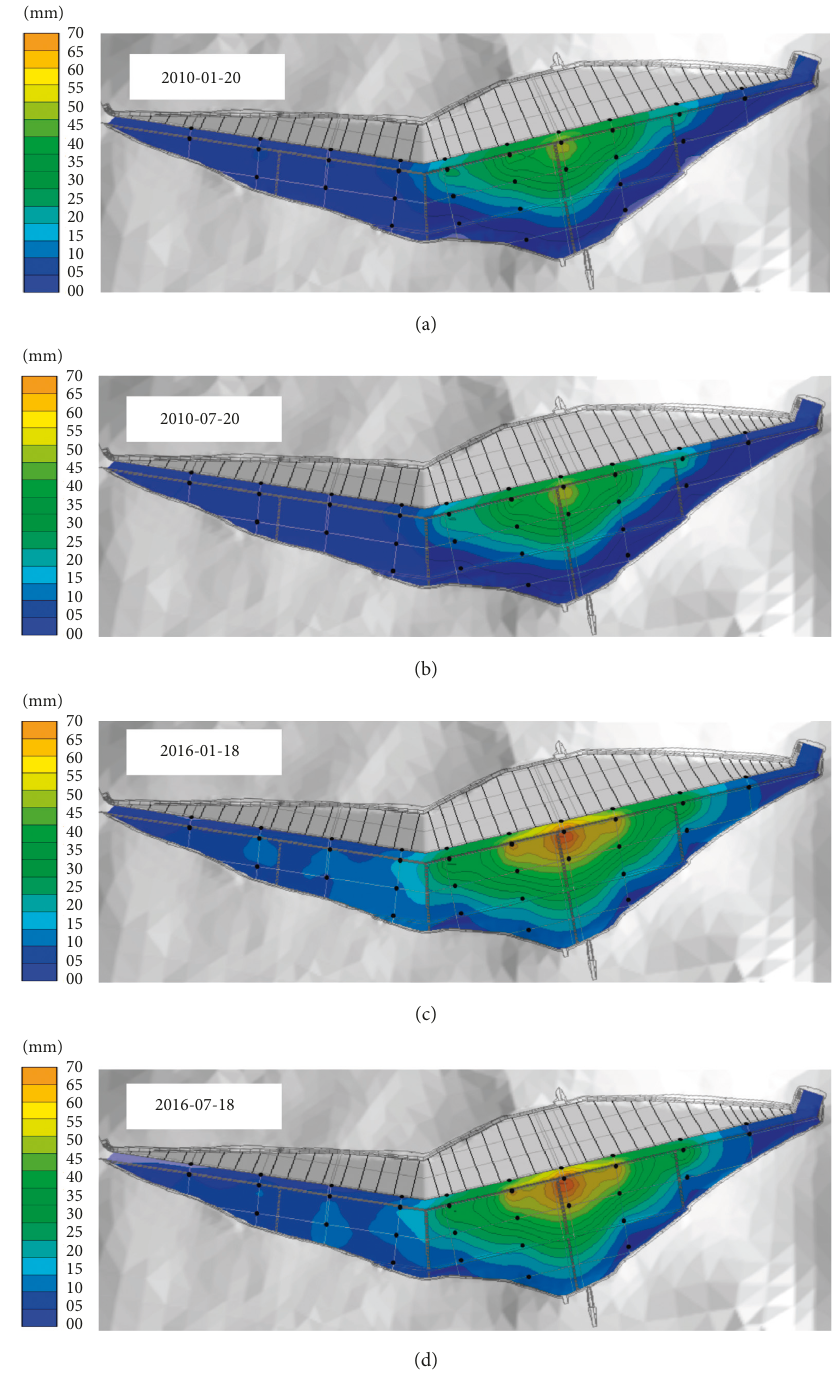
Figure 8: Settlement distributions of CFRD on typical days in 2010 and 2016